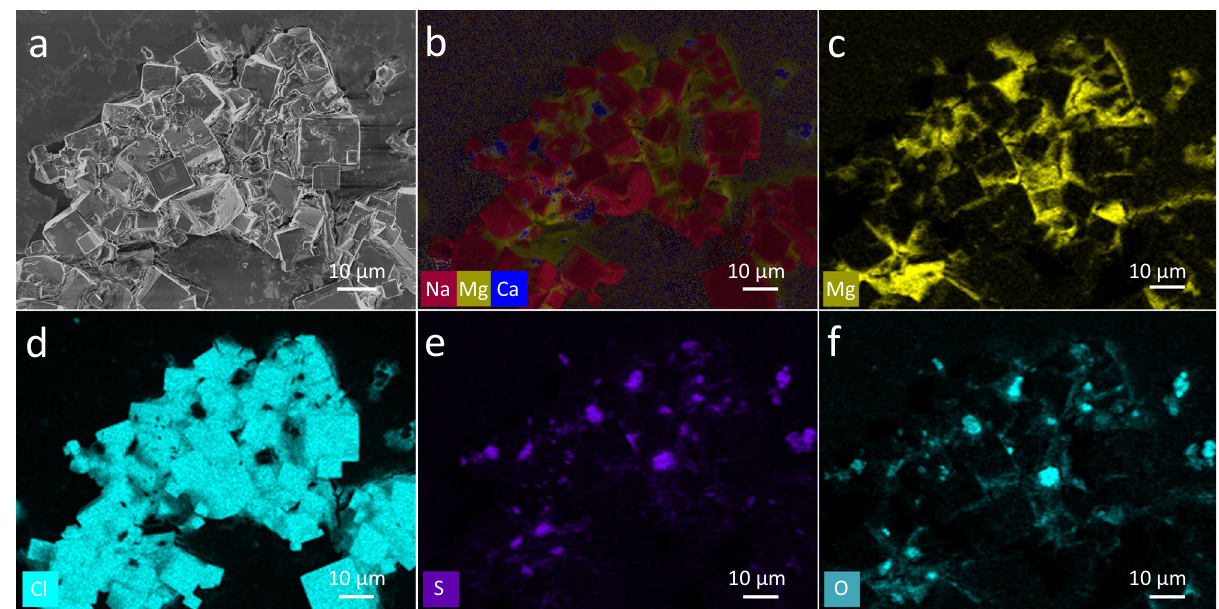
Fig. 6 The morphology of the crystals from concentrated RO brine and the corresponding ion distribution. a SEM image of the crystals after completely drying concentrated RO waste brine directly on wafer and the corresponding EDS maps of b metal elements, c magnesium, d chloride, e sulfur, and f oxygen.